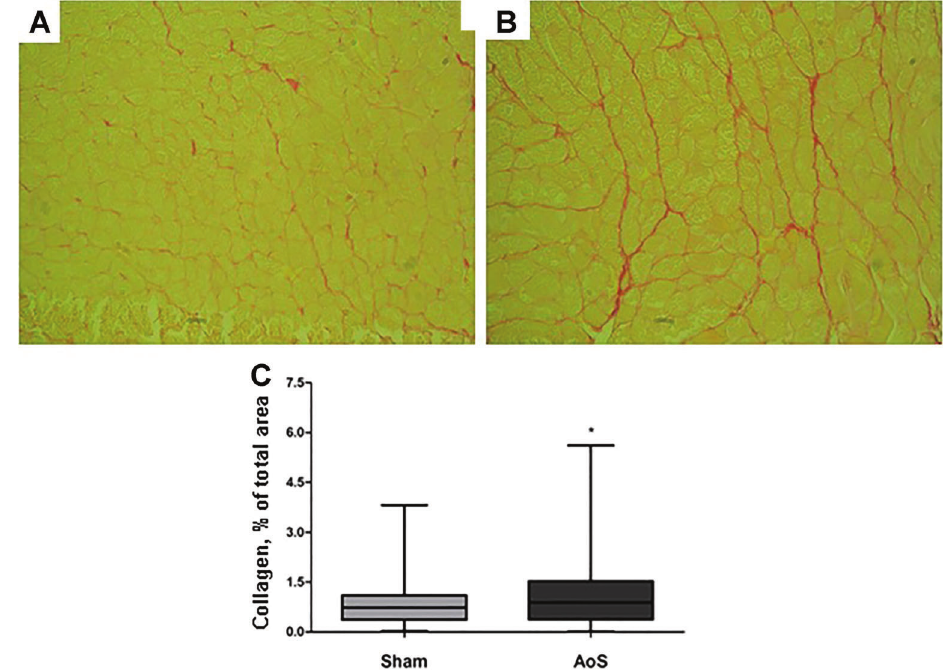
Figure 4. Histological image with Picrosirius red stain (40 (cid:4) ). A , Sham group; B , aortic stenosis (AoS) group. C , collagen level, % of total area analyzed with Picrosirius red technique from AoS (n= 8) and control groups (Sham, n=9). Data are reported as median, maximum and minimum. *P o 0.05 vs Sham (Mann-Whitney ’ s